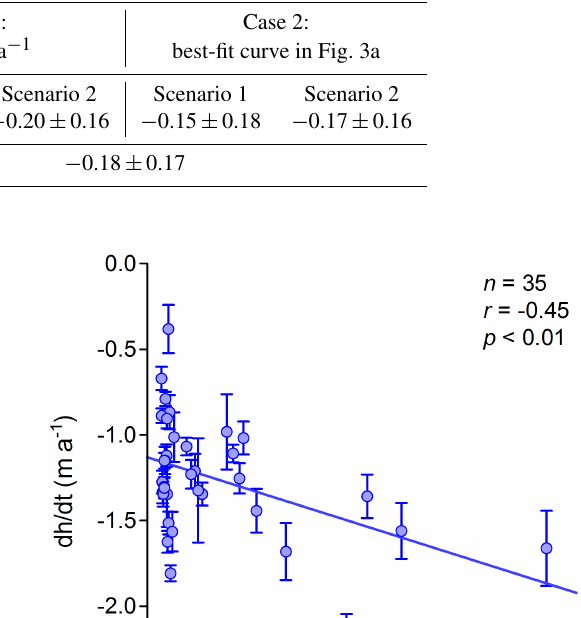
Table 3. Area-weighted geodetic mass balance of Kanchenjunga Glacier for the 1975–2010 study period (mw.e.a − 1 ). Two cases for the rate of elevation change, where DEMs are unavailable, and two density scenarios are assumed in our study. Scenario 1 assumes a constant density of 850 ± 60kgm − 3 for the entire glacier, whereas Scenario 2 assumes densities of 900 and 600kgm − 3 for the ablation and accumulation areas of the glacier, respectively. d h/ d t of the unmeasured Case 1: Case 2: area + 0.01ma − 1 best-fit curve in Fig. 3a